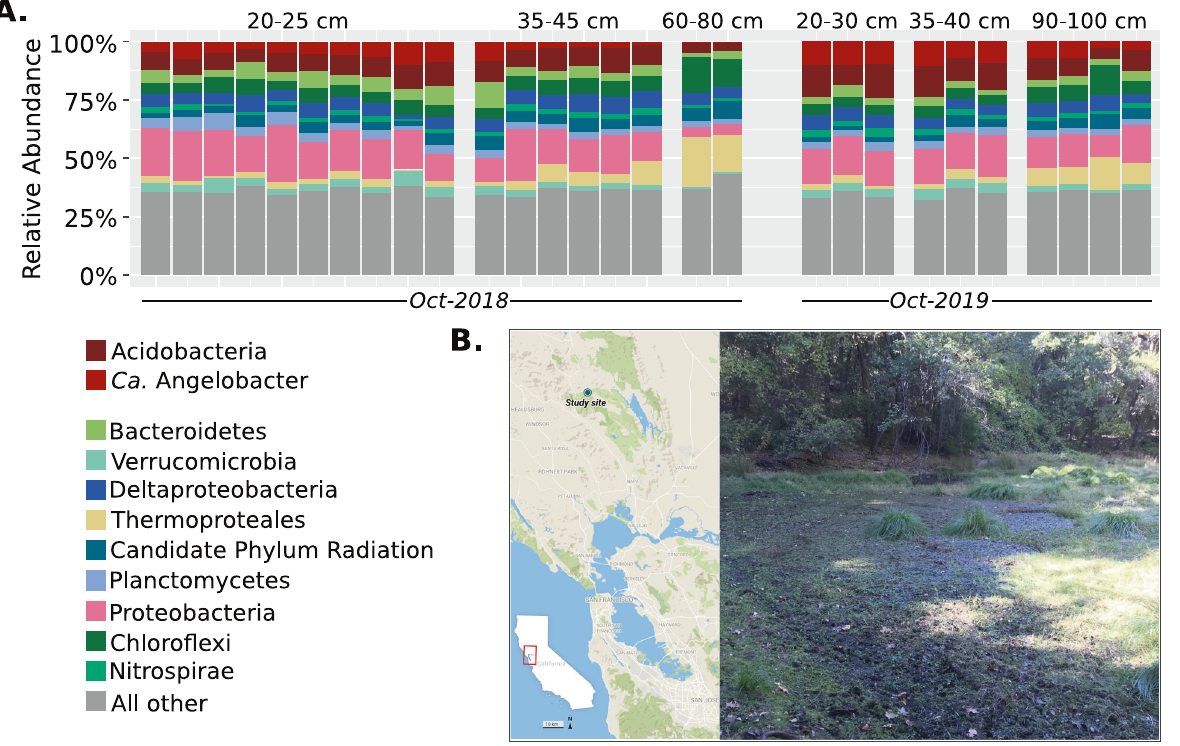
Fig. 1 Community composition of vernal pool soils. A Ribosomal protein (L6) abundances and taxonomic classi fi cations across all metagenomic samples obtained in this study. The abundances of Ca . Angelobacter ( Gp1-AA117) are shown separately from all other hits in phylum Acidobacteria. B Photograph of the vernal pool that was metagenomically sampled in this study, in Lake County, California,